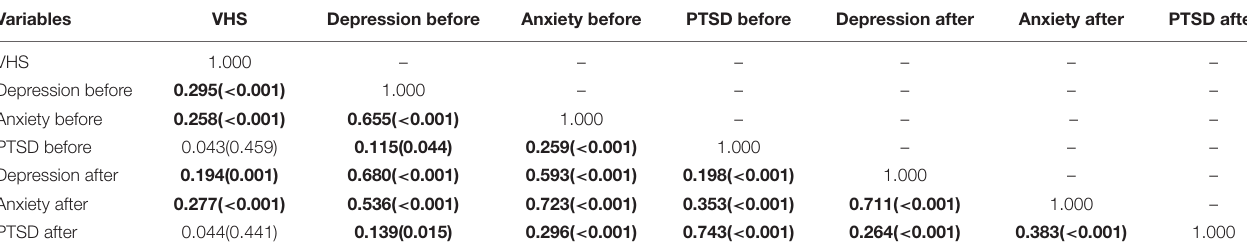
TABLE 7 | Correlation between scores in the K Saudi Arabian sample.